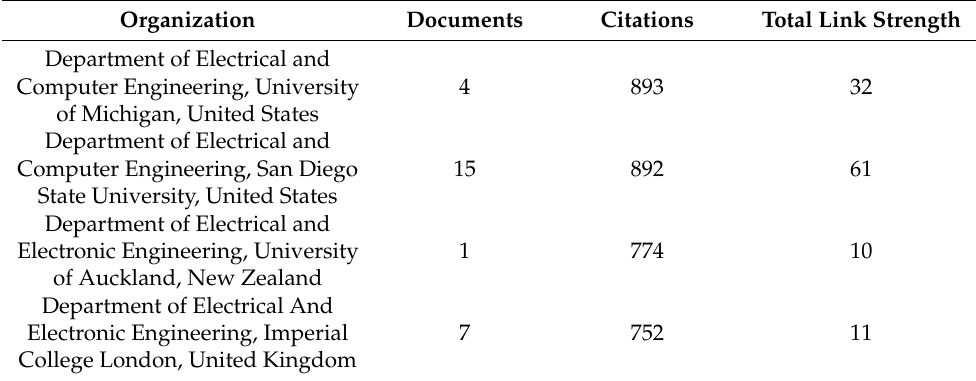
Table 5. Citation Analysis—List of Top Four Most Relevant Research